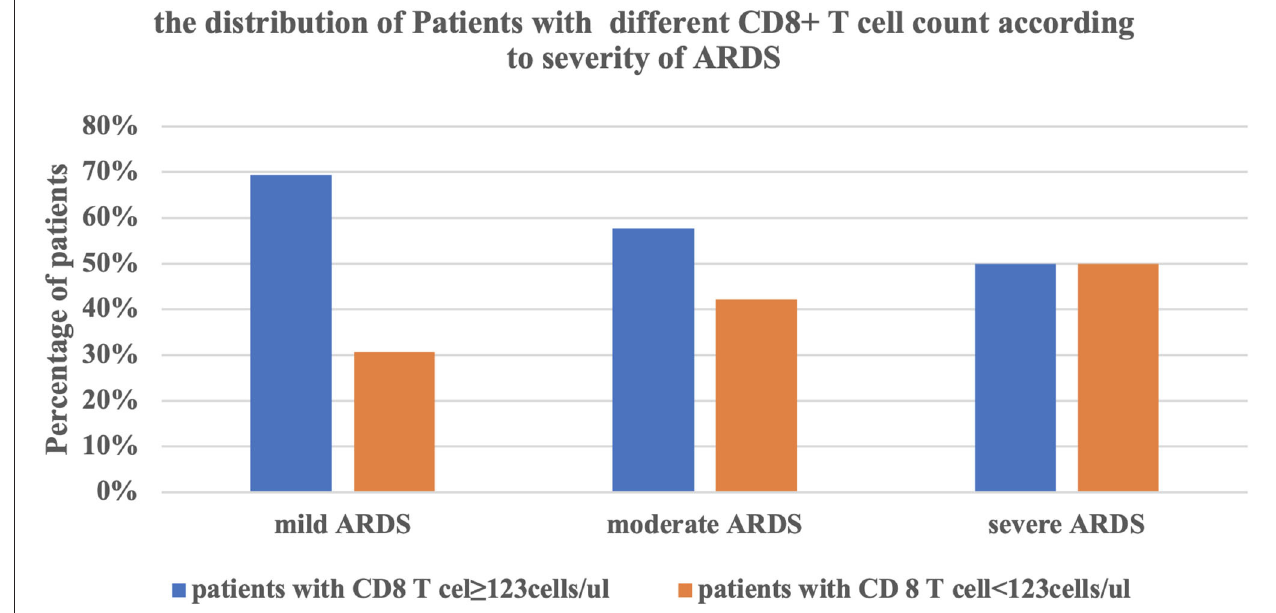
FIGURE 4 | The relationship between the severity of ARDS and the CD8 + T cell counts. ARDS, acute respiratory distress